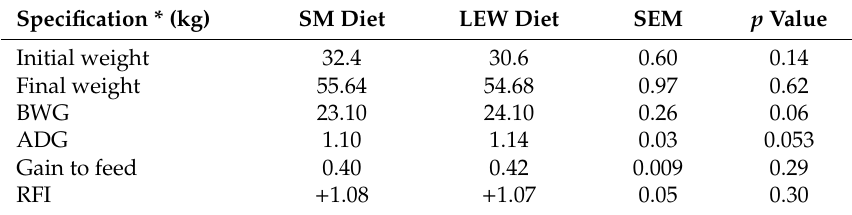
Table 3. E ff ect of dietary extruded linseed:walnut meal 50:50 ( wt / wt ) mix on growth performance. Specification * (kg) SM Diet LEW Diet SEM p Value Initial weight 32.4 30.6 0.60 0.14 Final weight